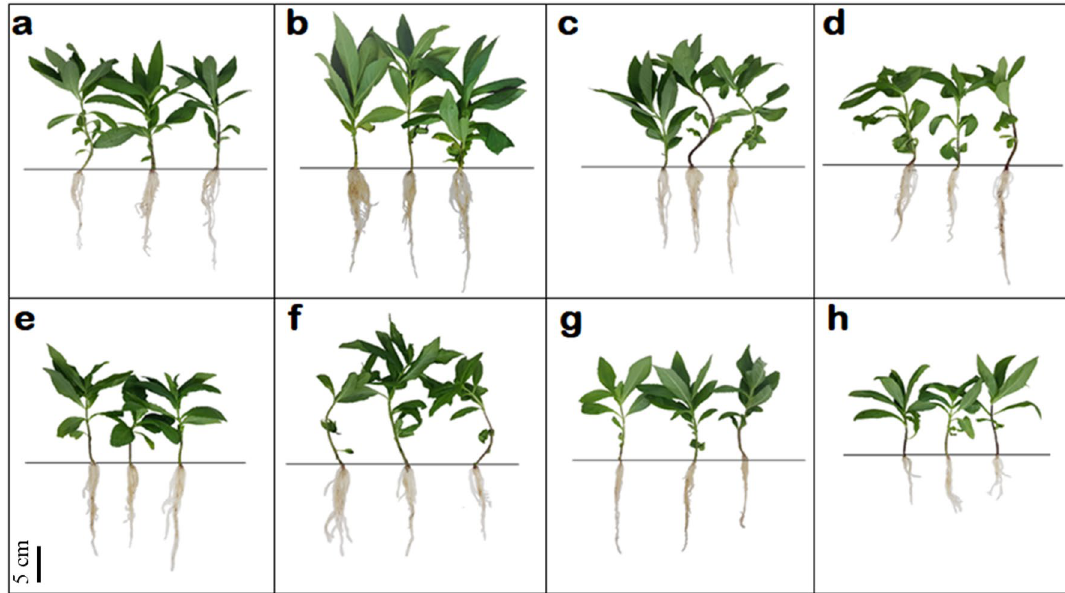
Figure 4. Comparison of shoot and root lengths of sampled representative A. africana plants derived from hormo-, halo- and hydro primed seeds after three months of growth ( a ) 1.44 × 10 − 5 GA 3 ( c ) 2.89 × 10 M GA 3 ( d ) 1.0 M KNO 3 ( e ) 0.5 M KNO 3 ( f ) 0.1 M KNO 3 ( g ) Distilled water ( h ) Non treated.